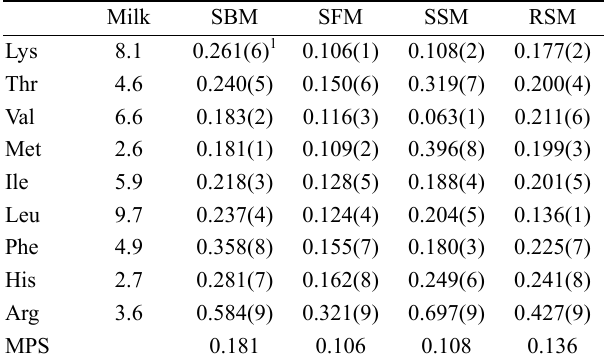
Table 8. Essential AA milk protein score of SBM, SFM, SSM and Table 7. Small intestinal absorbable AA contents of SBM,